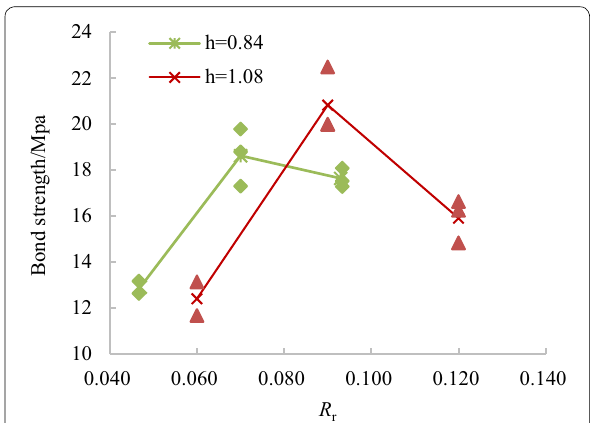
Fig. 11 Bond strength versus relative rib area.